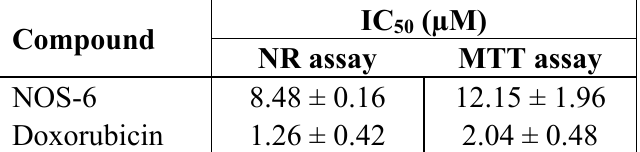
Table 1. Comparison of IC